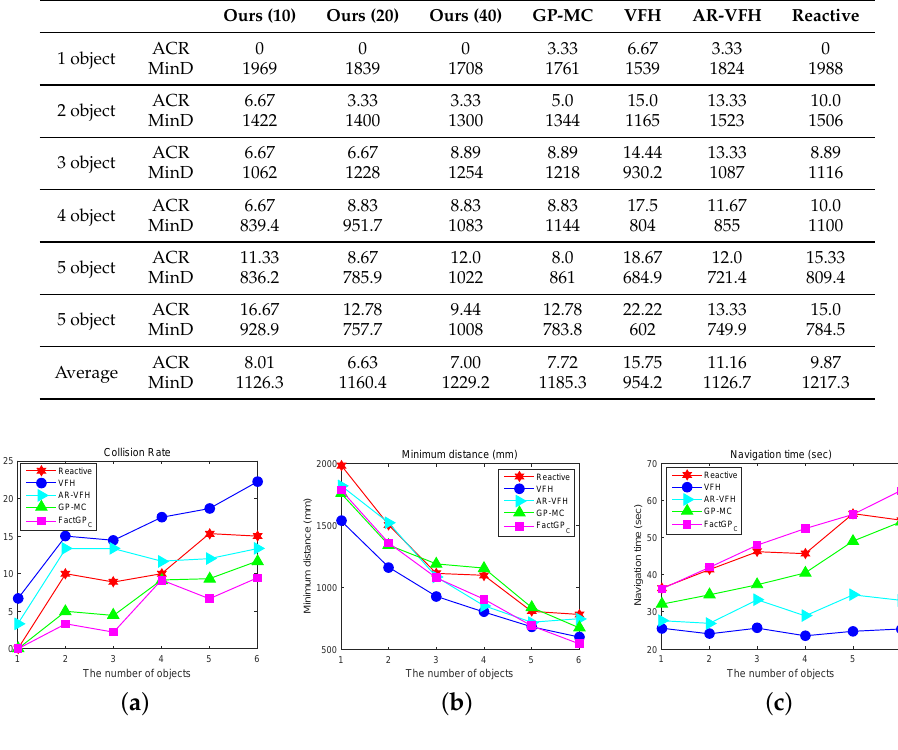
Figure 8. A comparison of motion controllers at different numbers of obstacles with respect to: ( a ) collision rate (%); ( b ) minimum distance (mm); and ( c ) navigation time (s). FactGP C (20) and GP-MC are trained using 3000 samples selected by